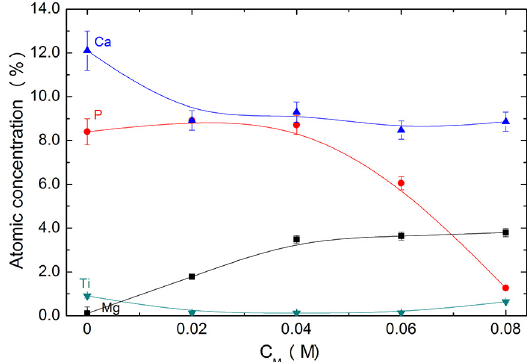
Figure 7. Average atomic proportion of elements in samples treated with different C determined by RBS in a 100 nm thick M superficial